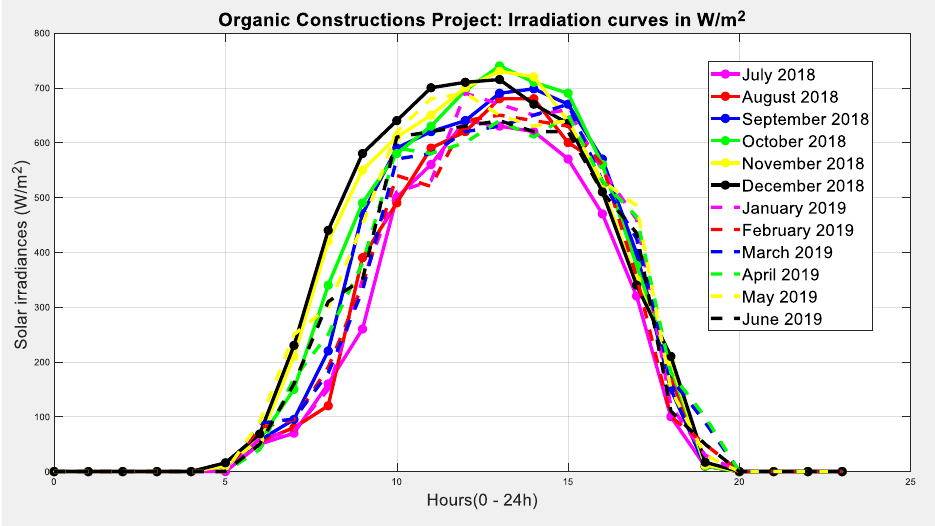
Figure 12. Solar irradiances profile (July 2018–June 2019).